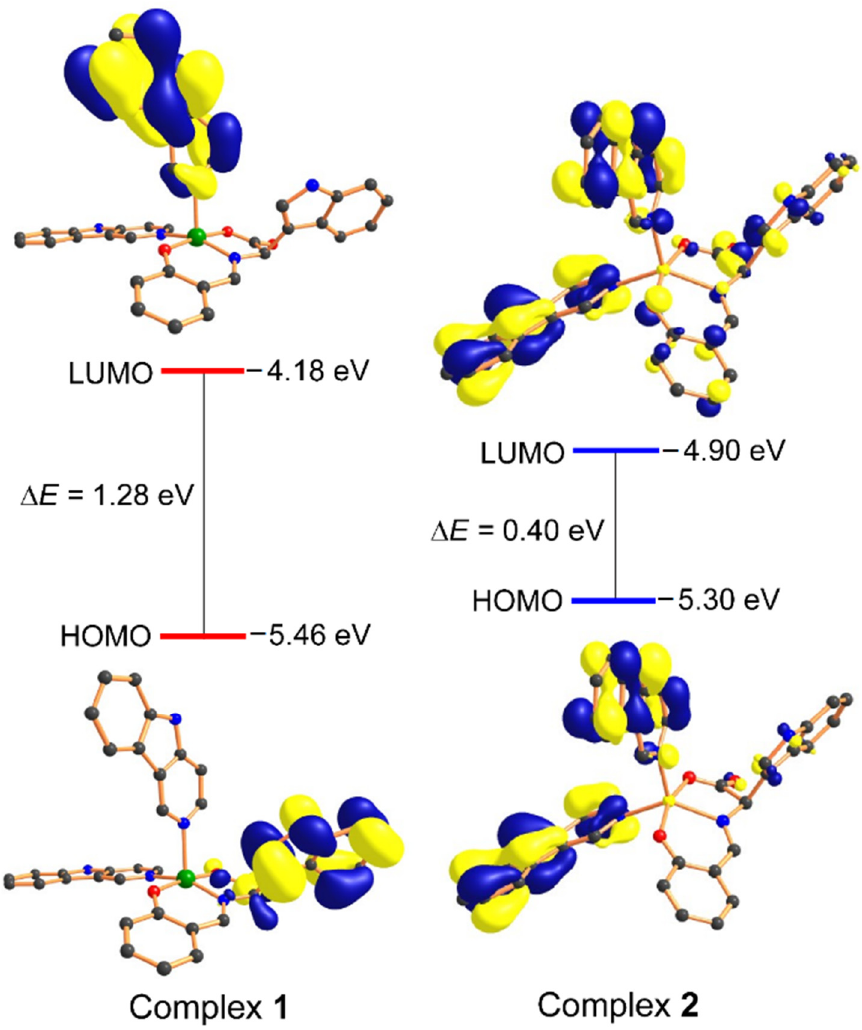
Figure 3. Frontier molecular orbitals of complexes 1 and 2 and their HOMO-LUMO energy